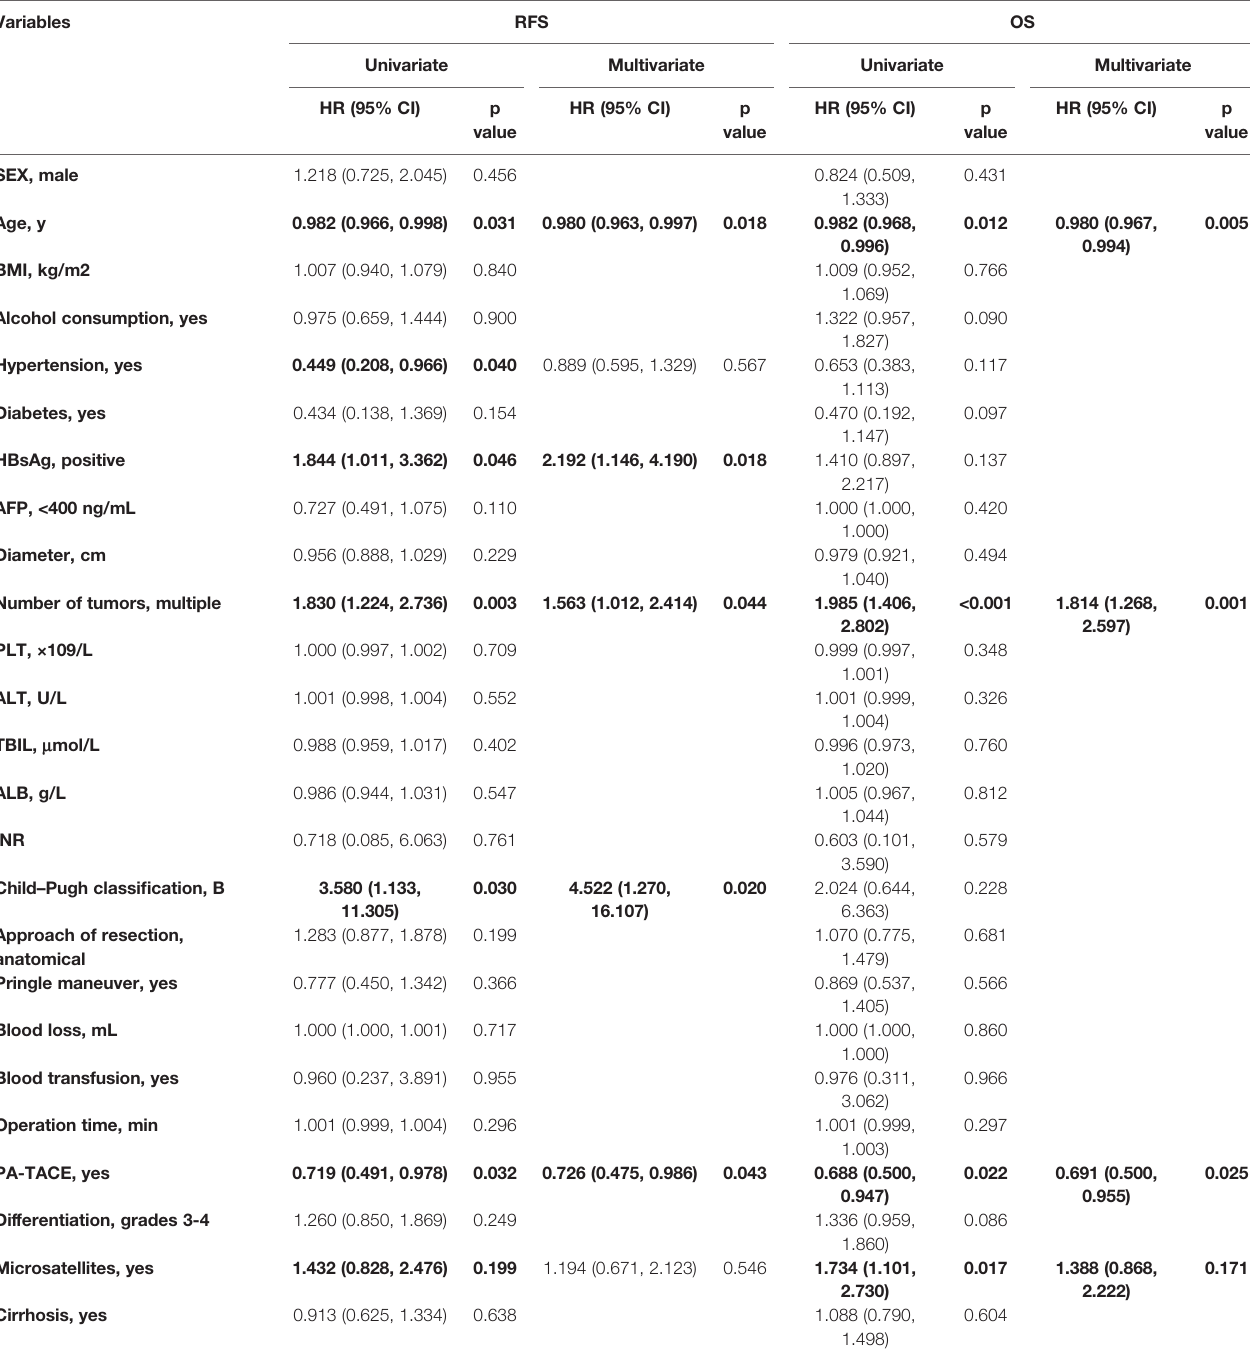
TABLE 4 | Univariate and multivariate analysis for RFS and OS in HCC patients without MPVI in the PSM